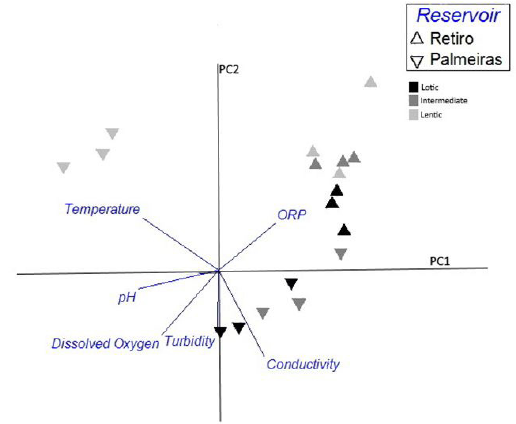
Figure 2. Graphic results of principal component analysis (components 1 and 2), based on the limnological characteristics adjacent to macrophyte banks in lotic, intermediate, and lentic compartments of Palmeiras and Retiro SHPs reservoirs, Sapucaí-Mirim River (SP,